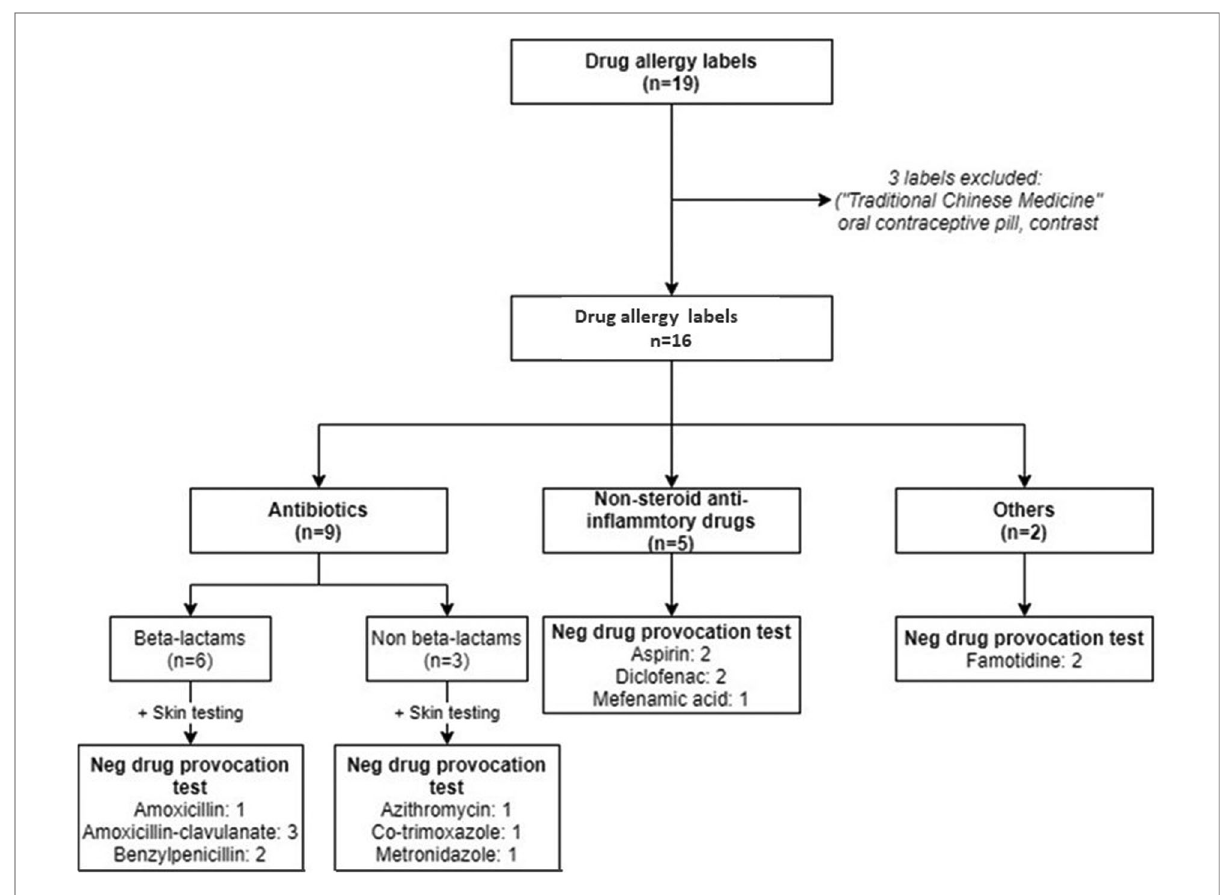
FIGURE 2 Allergy investigations and outcome of HAE patients with suspected drug allergy